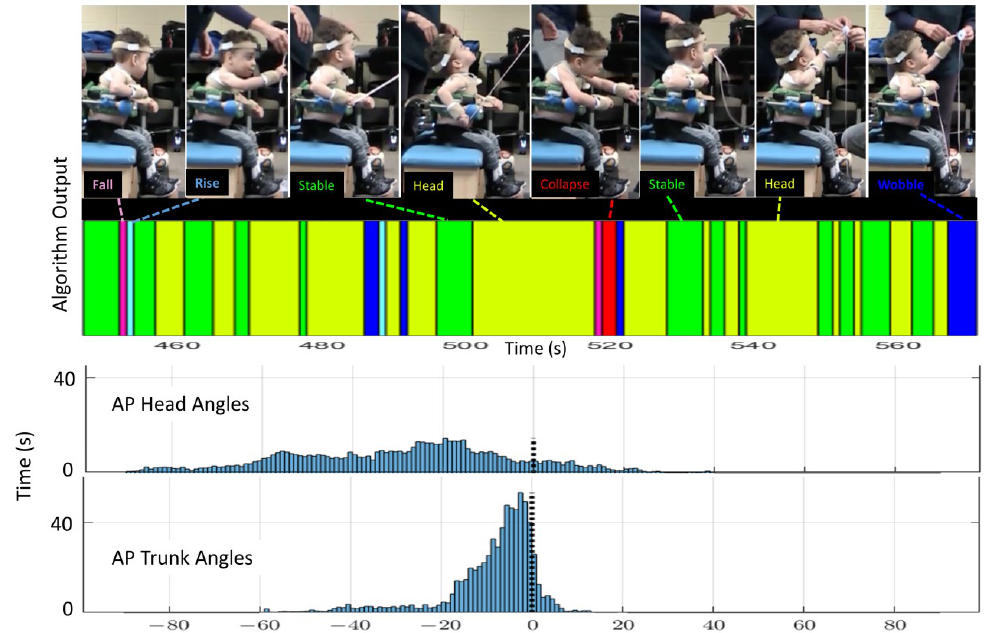
Figure 7. Example of algorithm output (colored bar), AP histograms (bottom) and images from video demonstrating AP alignment matched to algorithm output for subject 02KJ with mid-thoracic support. The histogram is qualitatively consistent with stable trunk and head not aligned some backward collapse is noted. For this child, the support provided a more upright and stable trunk however he tended to tip his chin upward and tilt his head back